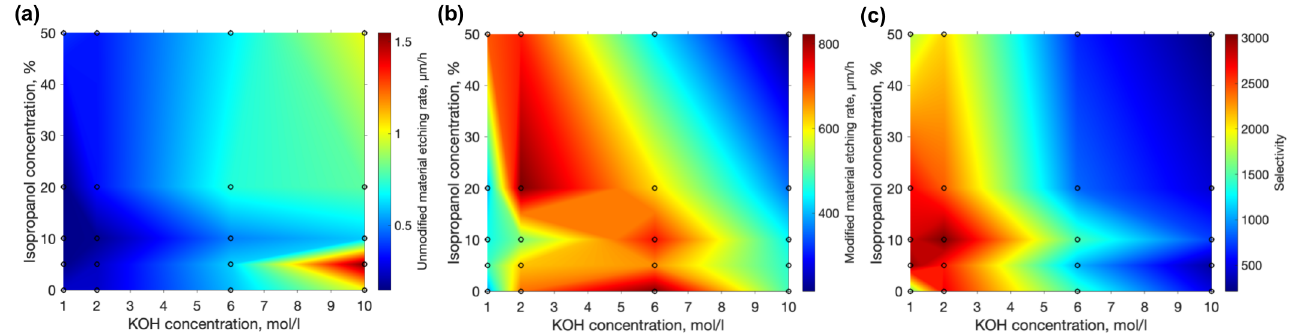
Figure 2. Etching rates of unmodified ( a ) and laser modified ( b ) fused silica acquired with dif- ferent KOH and isopropanol concentrations. The highest achieved values are ∼ 1.50 µ m/h and ∼ 820 µ m/h respectively. ( c ) selectivity is derived by dividing results of part ( b ) by part ( a ). The highest value is ∼ 3000 at 2 mol/L KOH and 10% isopropanol, showing a clear tendency that lower KOH concentrations and a moderate amount of isopropanol positively impact the